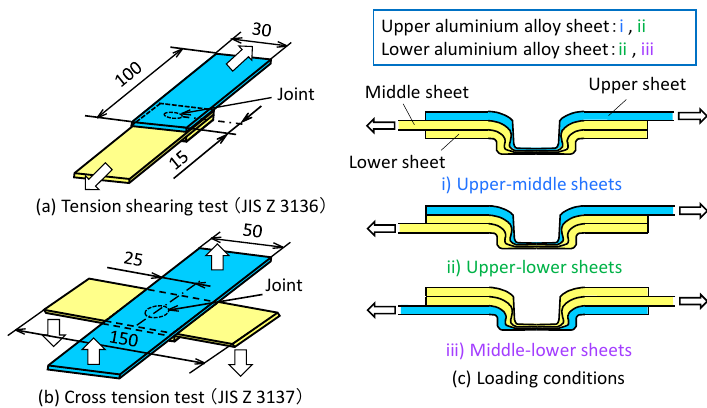
Figure 27. Measuring conditions of joint strength: ( a ) tension-shearing test (JIS Z 3136); ( b ) cross-tension test (JIS Z 3137); ( c ) loading conditions.